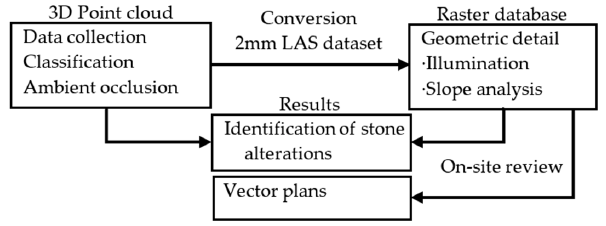
Figure 1. Methodology and structure of the article.